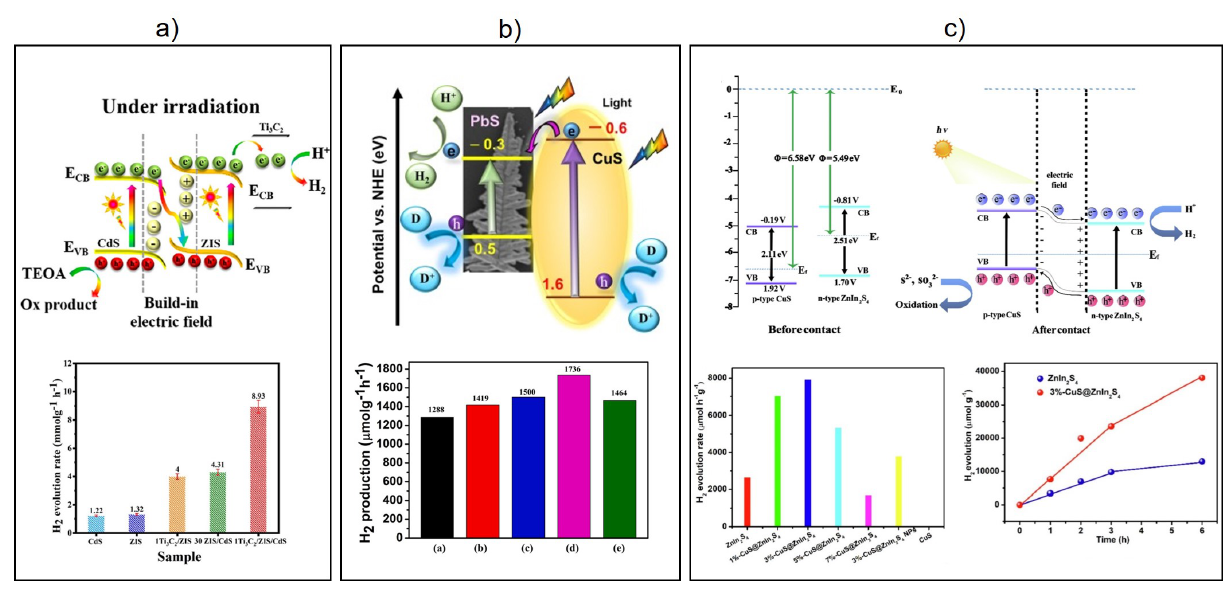
Figure 15. Photogenerated charge carrier transfer mechanisms for different MS-based hierarchical photocatalysts during the hydrogen evolution reaction. ( a ) Zn 1 − x Cd x S/CdS [144] Copyright 2022, Elsevier. ( b ) CuS/PbS [145] Copyright 2021, Elsevier. ( c ) CuS@ZnIn 2 S 4 [146] Copyright 2022, Elsevier. Corresponding HER plots are shown in the bottom panel. In fig ( b ) bottom axis, ( a ) corresponds to clean PbS, while ( b – e ) correspond to the Cu/Pb ratio of 0.414, 0.446, 0.578, 0.452,